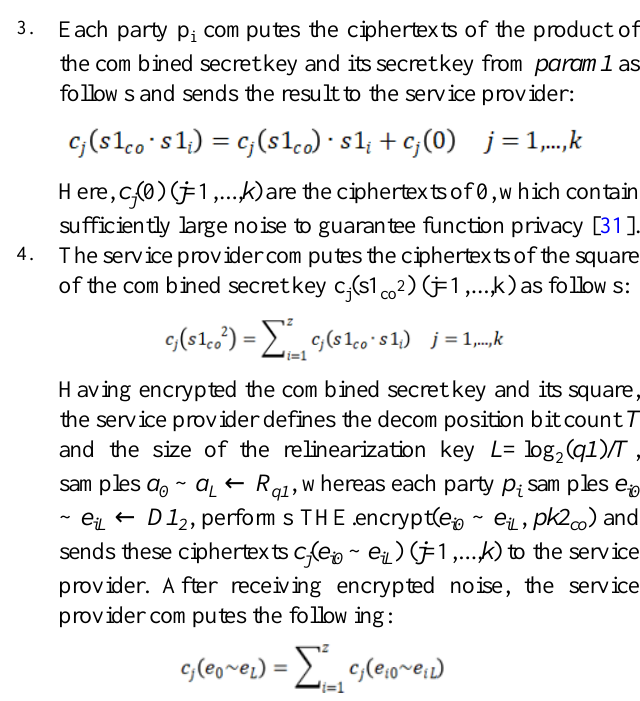
Key Generation and Data